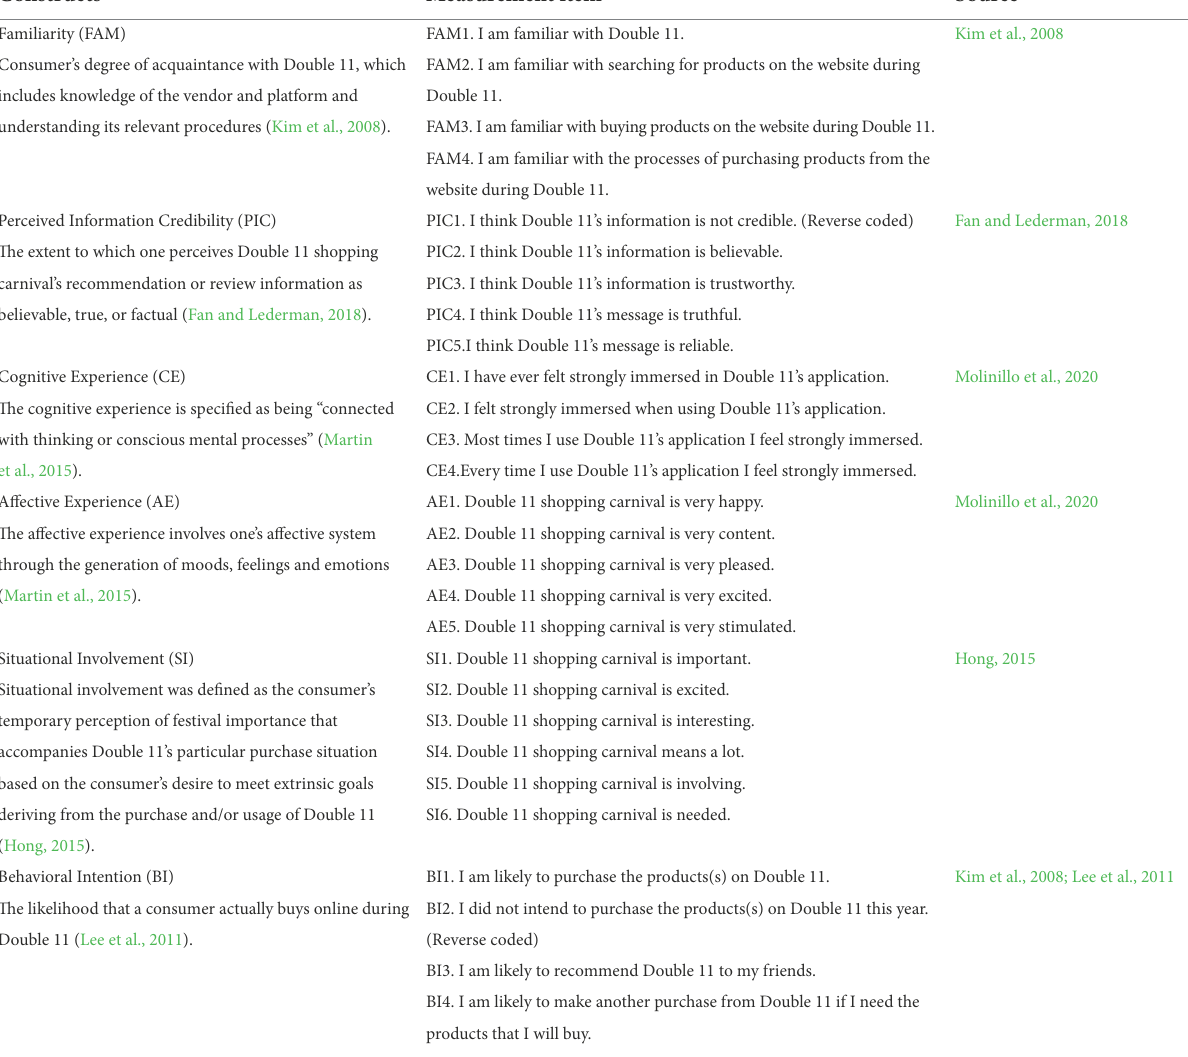
TABLE 1 Operational definitions and scale items of constructs.